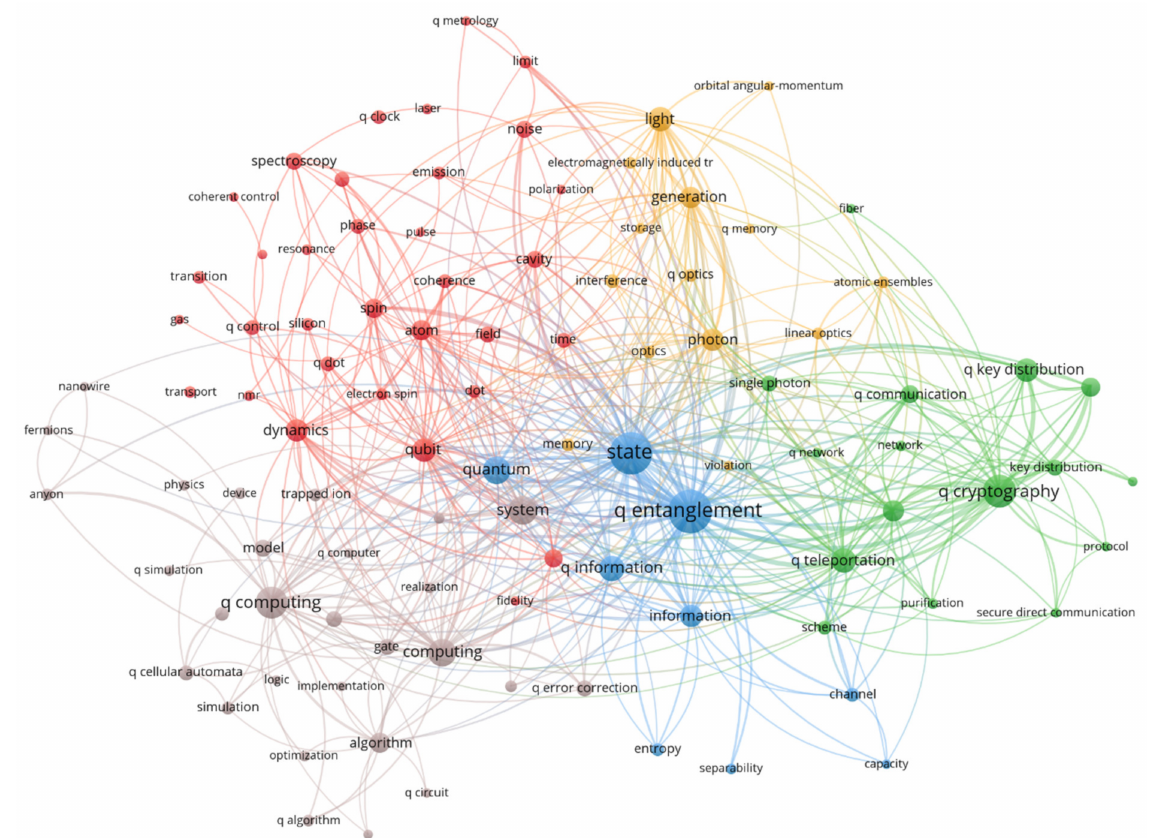
Figure 8. Co-occurrence map of the top 100 keywords (author keywords and keywords plus from 2012 to 2018) with five topical clusters, using the VOSviewer parameters resolution = 1.0 and minimal cluster size = 5. For better readability, in compound keywords the term quantum is abbreviated to q. Readers interested in an in-depth analysis of our publication set can use VOSviewer interactively and zoom in on the clusters. An online version is provided at https://s.gwdg.de/N5TmUa (accessed on 1 August 2021) (cluster colors probably